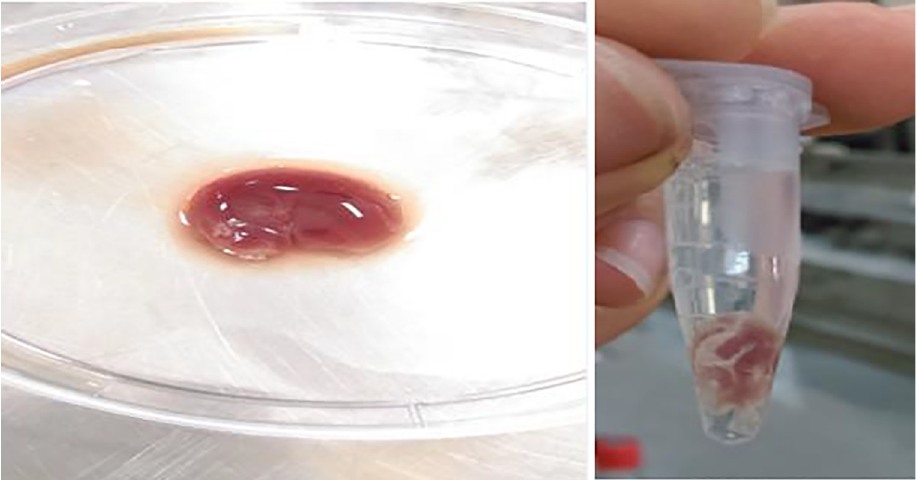
Fig 1. Coagulated media in a plate (left) and in a microtube (right). Wound-Like Medium containing heparinized human plasma, 45% Bolton broth base, 1% gelatin, and 5% laked sheep red blood cells, was inoculated with 10 μ l of the combined and normalized culture (1 × 10 6 CFU/ml) of S . aureus-P . aeruginosa bacteria. After 24 h incubation at 37˚ C, media was coagulated.